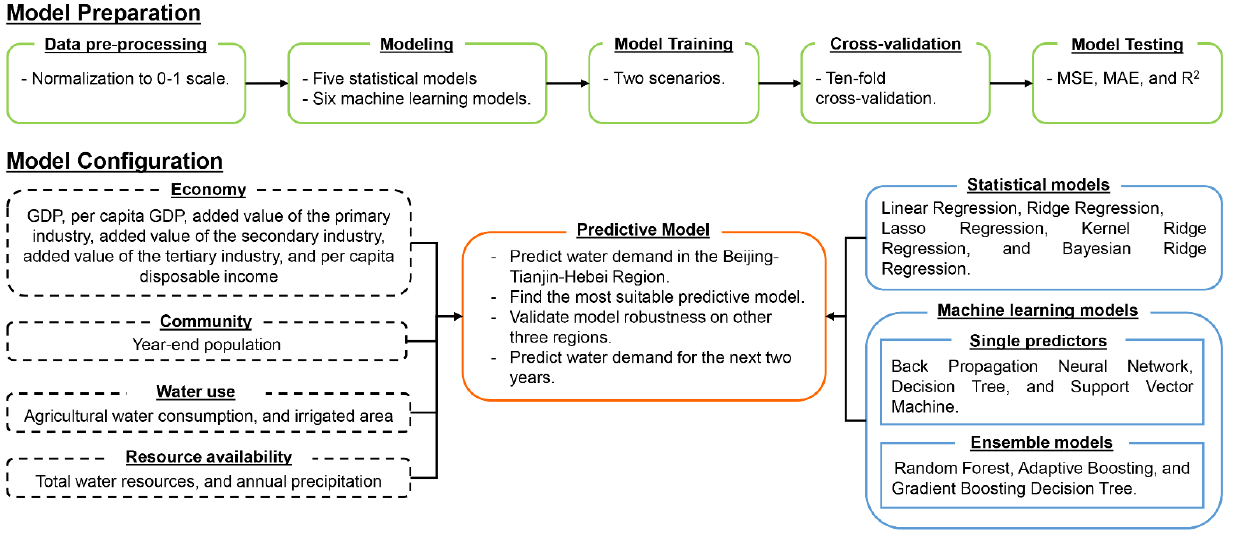
Figure 1. Research design.